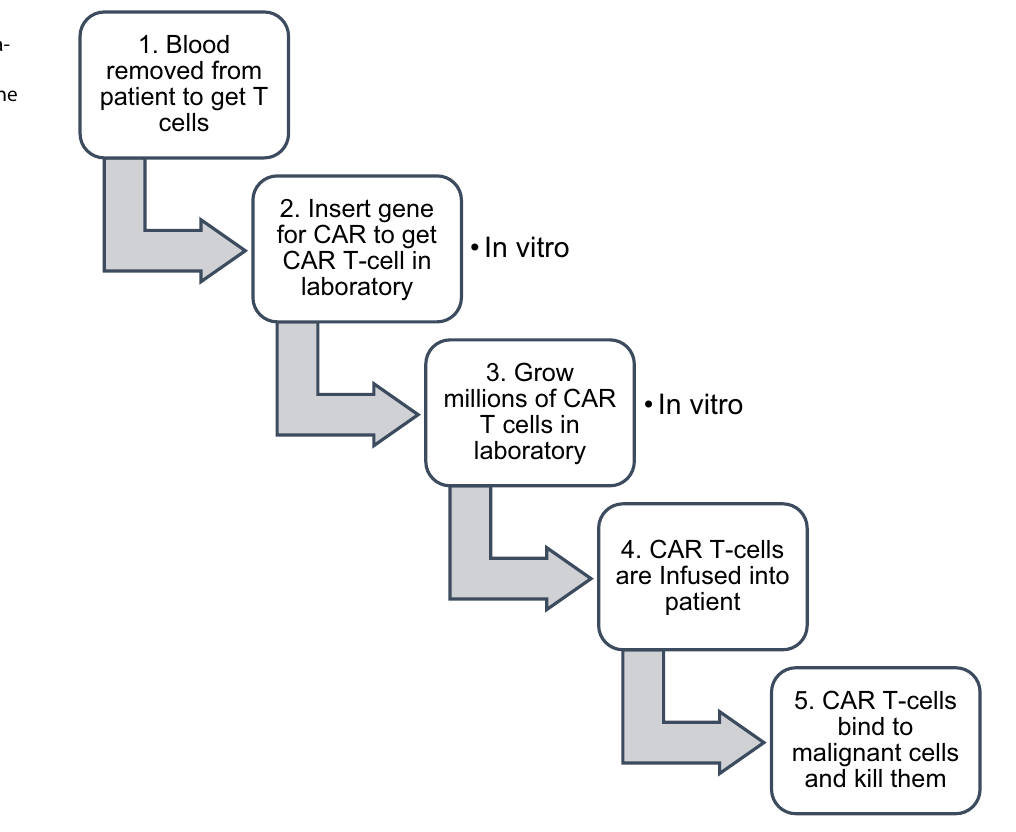
Fig. 2 CAR T-cell therapy procedure (currently prepara- tion of CAR T-cells is done in vitro, research is being done to prepare CAR T-cells inside